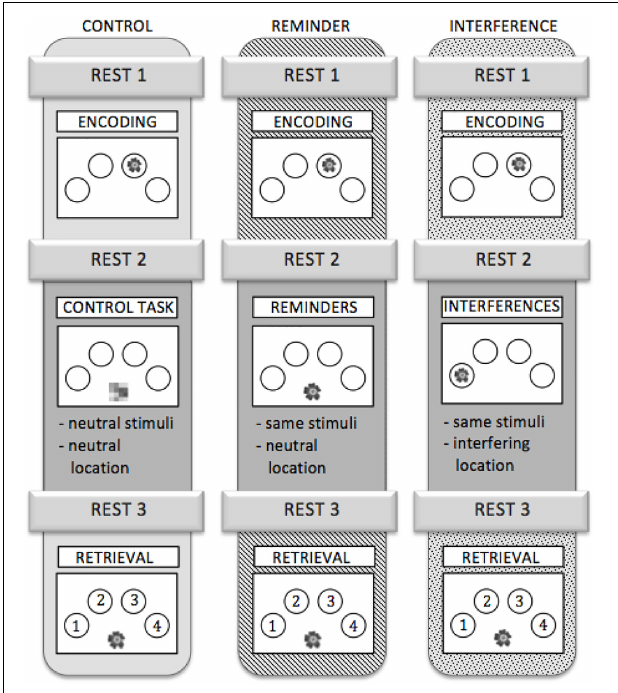
FIGURE 2 | Outline of the three scanning sessions. Each participant completed all three sessions. The sessions were assigned to the subjects in a randomized